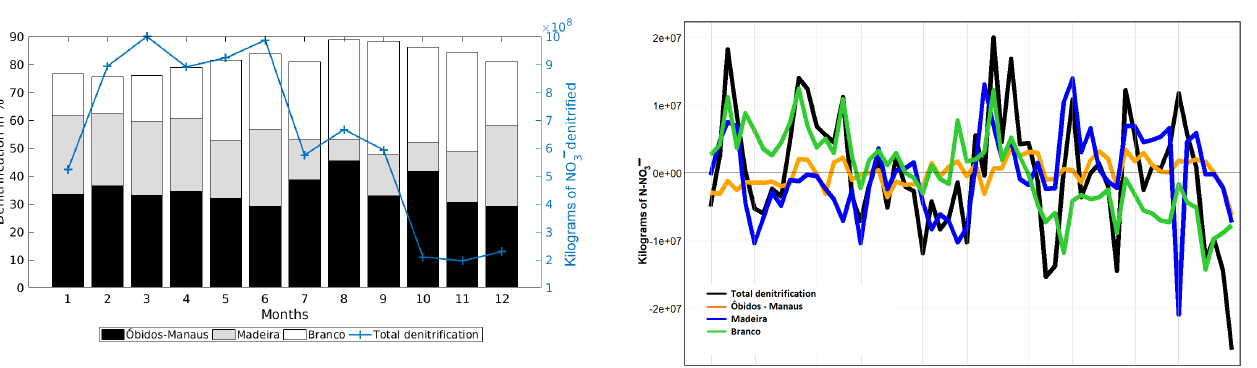
Figure 7. Average monthly contribution of each floodplain – the O– M FP (black), the Madeira FP (grey) and Branco FP (white) – to the Amazon total denitrification. The residual contribution to make up 100% is associated with the other wetlands in the basin. The blue line represents the average monthly denitrification for the period of the study, and it shows the main trend observed over the Amazonian watershed.